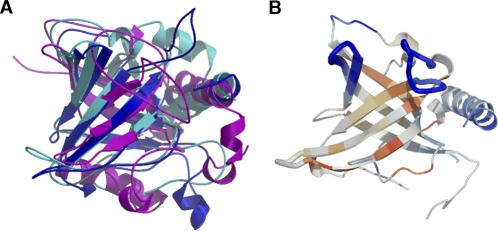
ML Superposition and PCA Plot of Homologous Telomere Domains(A) An ML superposition of the first OB-fold from 1otc (blue), 1s40 (magenta), and 1qzg (cyan).(B) A PCA plot of the first principal component based on the ML superposition in (A), plotted on the mean structure. Two functionally critical loops, shown in blue, are implicated in telomeric ssDNA substrate recognition. These loops are highly correlated, indicating that their conformations have evolved in concert.